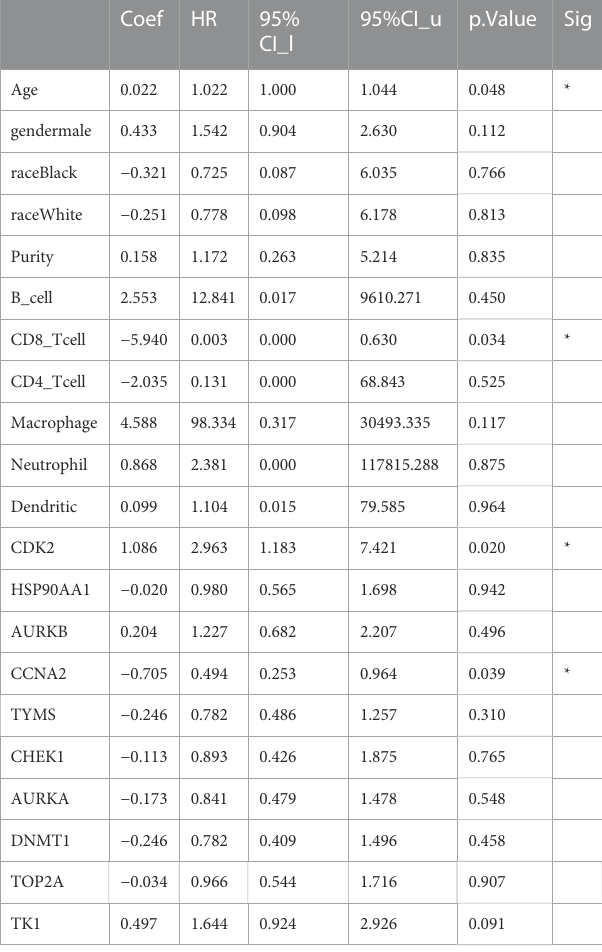
TABLE 6 Cox proportional hazard model for hub genes and tumor-in fi ltrating immune